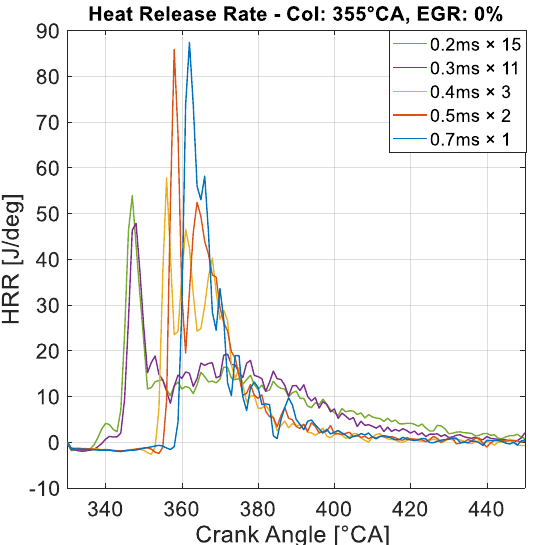
Figure 11. The heat release rates of the investigated structures with the same dose in the function of the crank angle without EGR. The CoI is 355 °CA in each case.